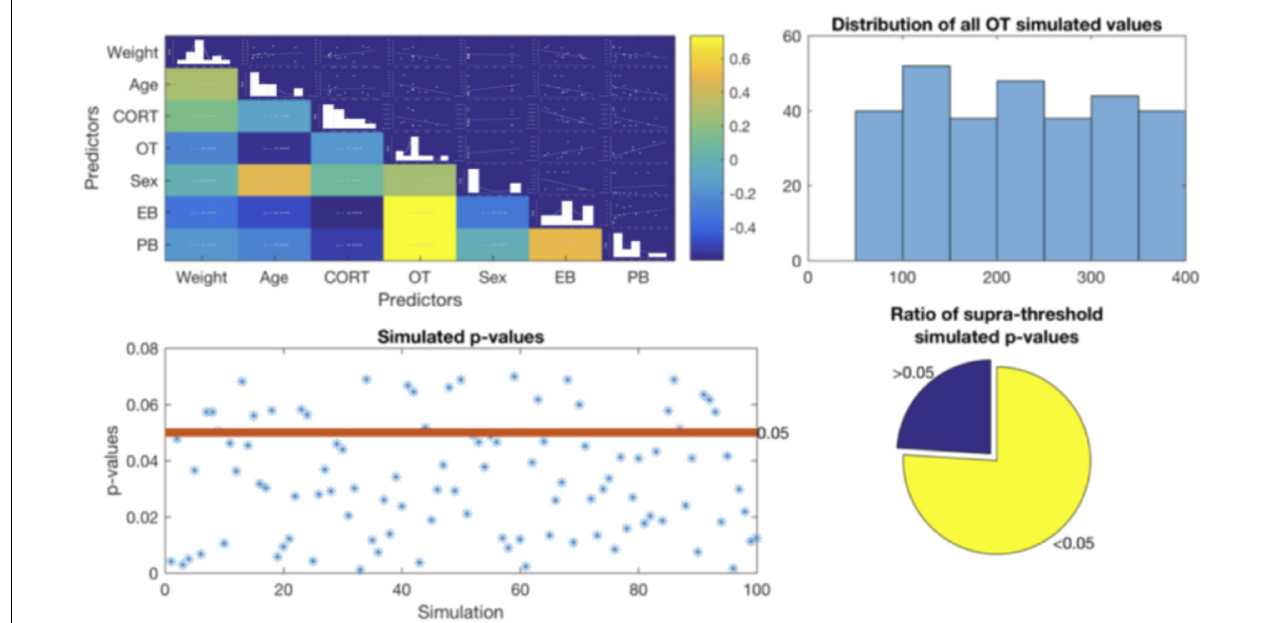
FIGURE 1 | Top Left – Correlation matrix between all variables. Top right – distribution of all OT simulated values showing no tendency. Bottom left – all p -values obtained from the simulated data. Red line indicates the considered statistical threshold, less than 30% of these p -values were above threshold (bottom